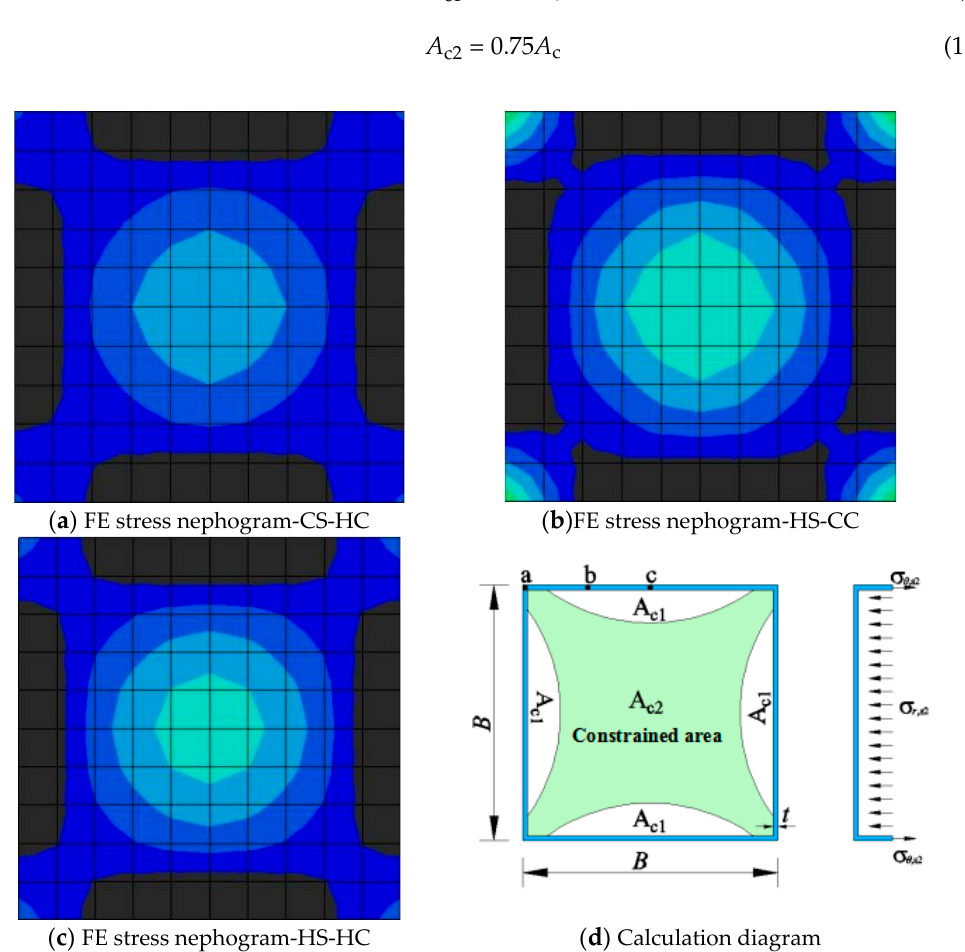
Figure 10. Simplified stress distribution model at the mid-height section of CFST stub columns.